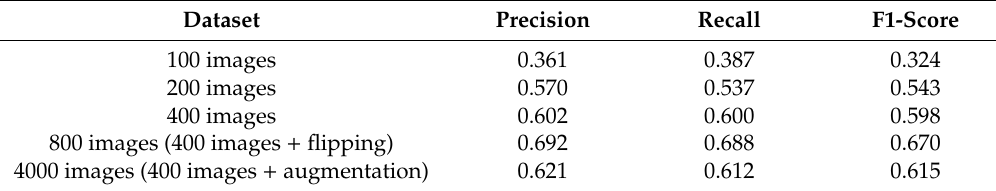
Table 6. Changes in model performance characteristics with respect to the training dataset